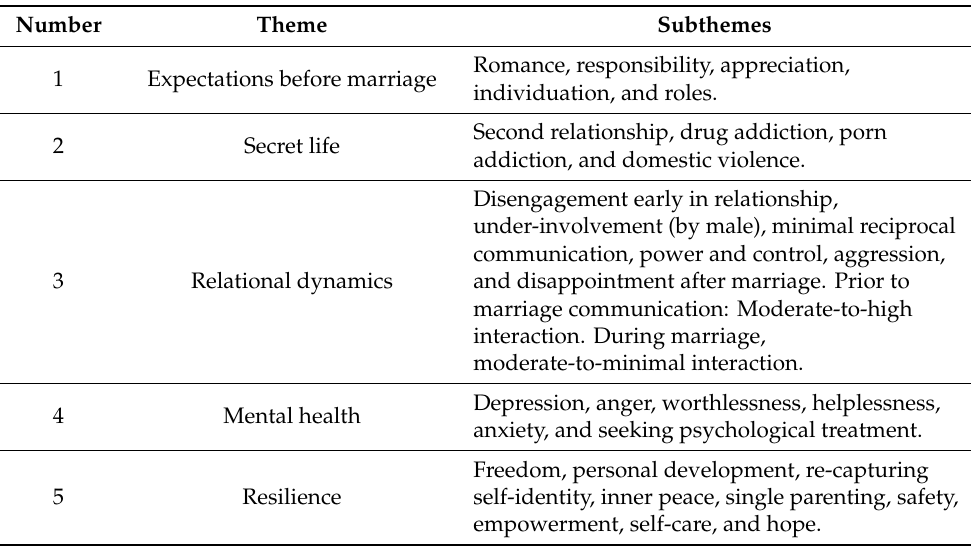
Table 1. Emerging themes and